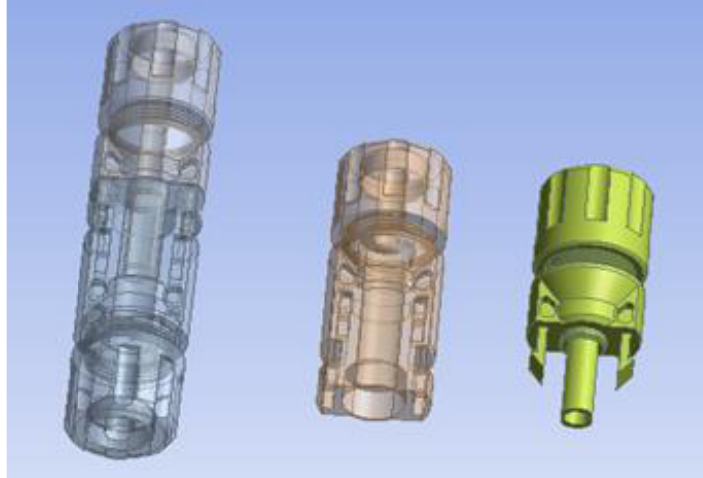
Figure 6. Analyzed MC4 connectors (simulation with ANSYS).